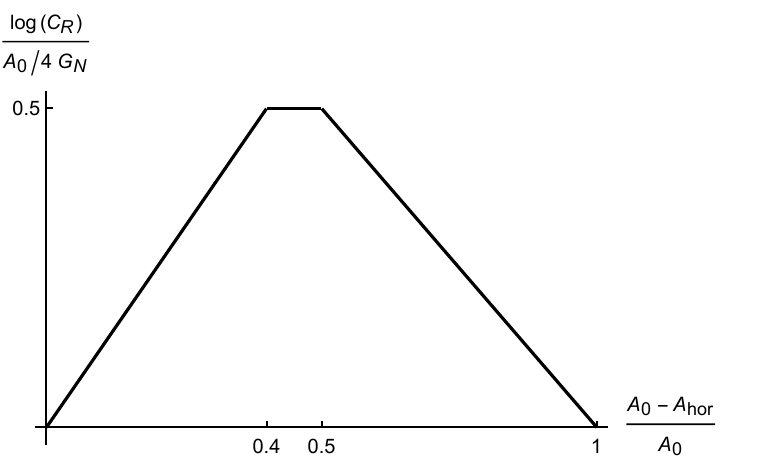
Figure 20 . A plot of our conjecture for log the purposes of this plot we have assumed S rad = 1 : 5( A 0